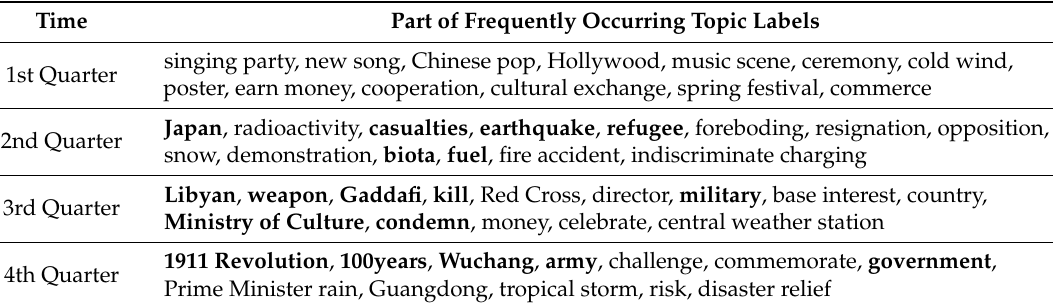
Figure 13. Hot topic community results in different quarters. Table 3. Part of frequently occurring topic Table 5. Hot topics from each social networks.